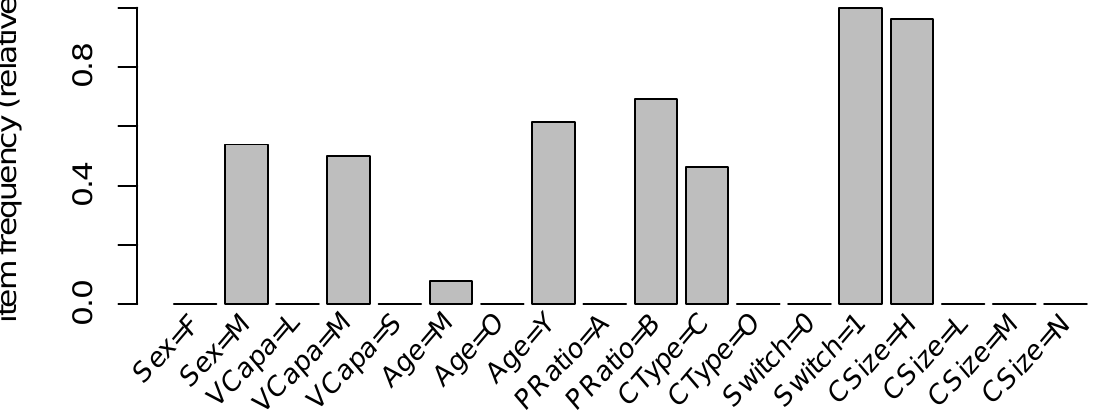
Figure 8. Relative frequency of itemsets in the association rules for policy